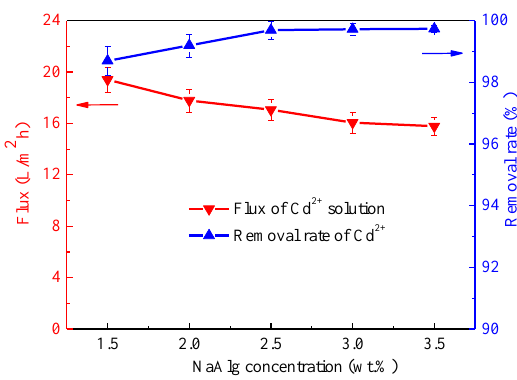
Figure 8. The effect of NaAlg concentration on the flux and removal rate of Cd 2+ . Coatings 2019 , 9 , x FOR PEER REVIEW